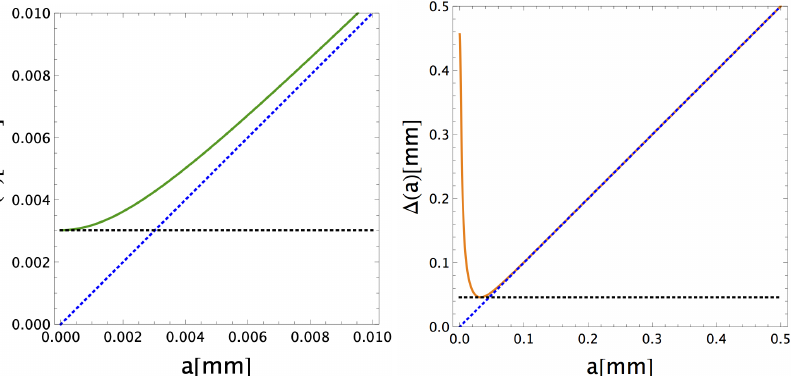
Figure 3. Graphical identification of the width limit a (cid:48) defined as in Equation (35), as the object width coinciding with the minimum of the total image width ∆ ( a ) . The solid lines represent ∆ ( a ) , while the dashed lines, corresponding to ∆ ( a ) = a , are reported to show the onset of proportionality between image and object width. The horizontal dashed lines represent the minimum value of ∆ ( a ) . The left panel represents the case z = z a , in which the object is placed in one of the two reference planes, focused on the detector, and δ is a constant. The right panel shows the case in which the object is placed midway between the two reference planes, namely in z = ( z a + z b ) /2. Numerical values of the parameters are reported in the text.